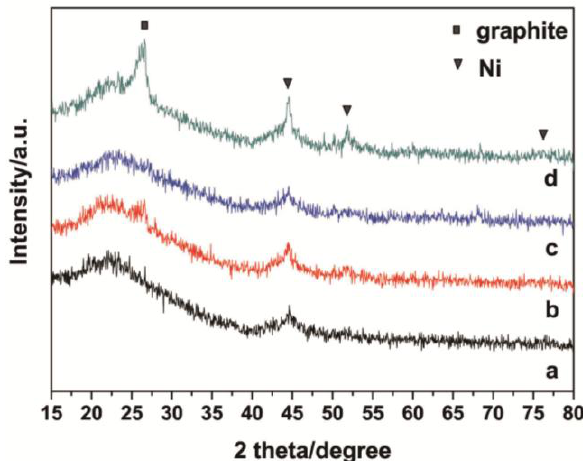
Figure 9. XRD patterns of ( a , c ) the reduced and ( b , d )used catalysts. ( a ) and ( b ) 6.7%Ni-SiO ( c ) and ( d ) 8.8%Ni-SiO